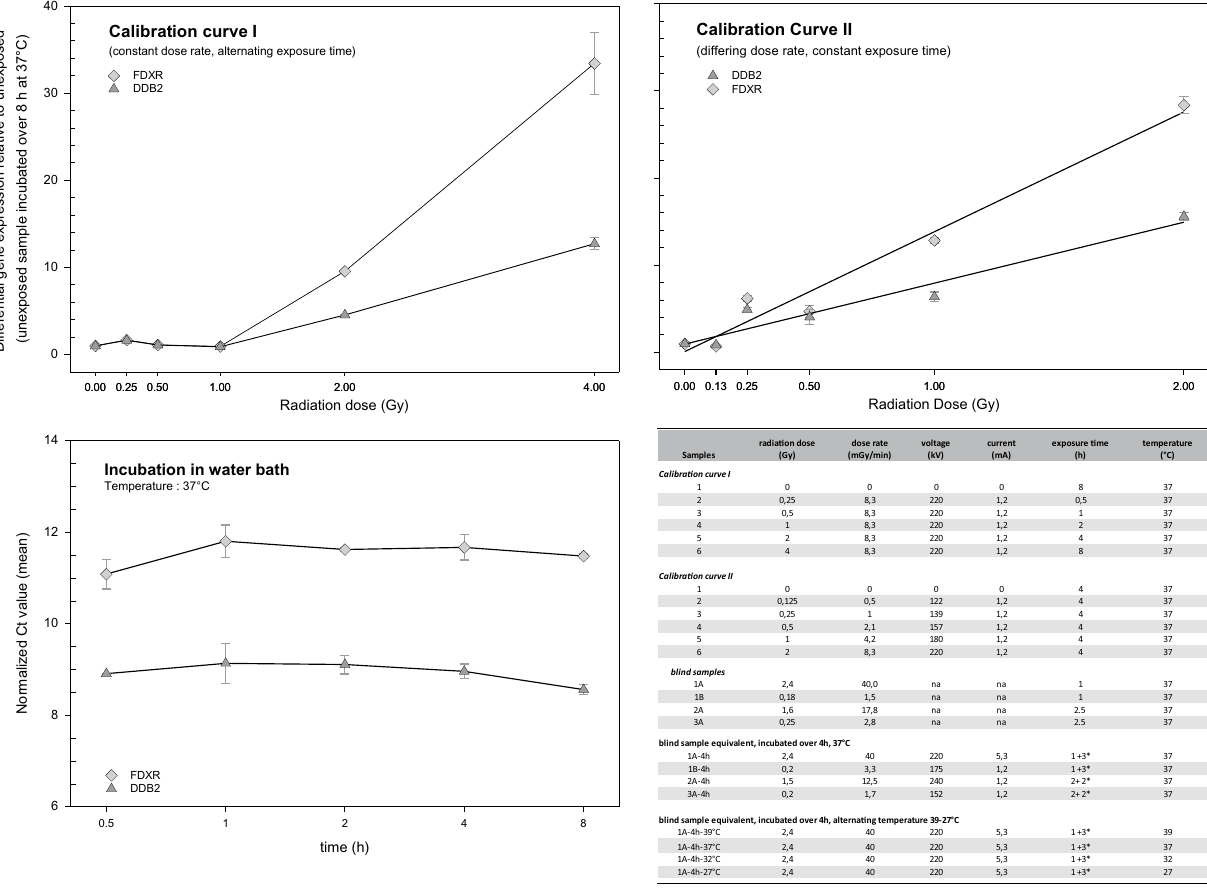
Blind samples, calibration curves I and II, addi- tional calibration curve (generated in